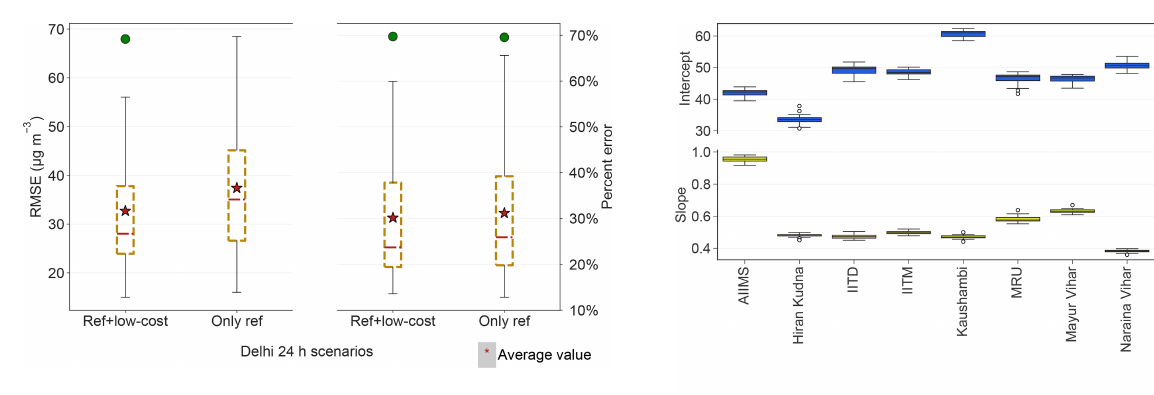
Figure 5. Box plots of the GPR model 24h performance scores (in- cluding RMSE and percent error) for predicting the measurements of the 22 holdout reference nodes across the 22-fold leave-one-out CV under two scenarios – using the full sensor network by includ- ing both reference and low-cost nodes and using only the reference nodes for the model construction. Note both scenarios were given the initial parameter values and bounds that maximize the model performance.